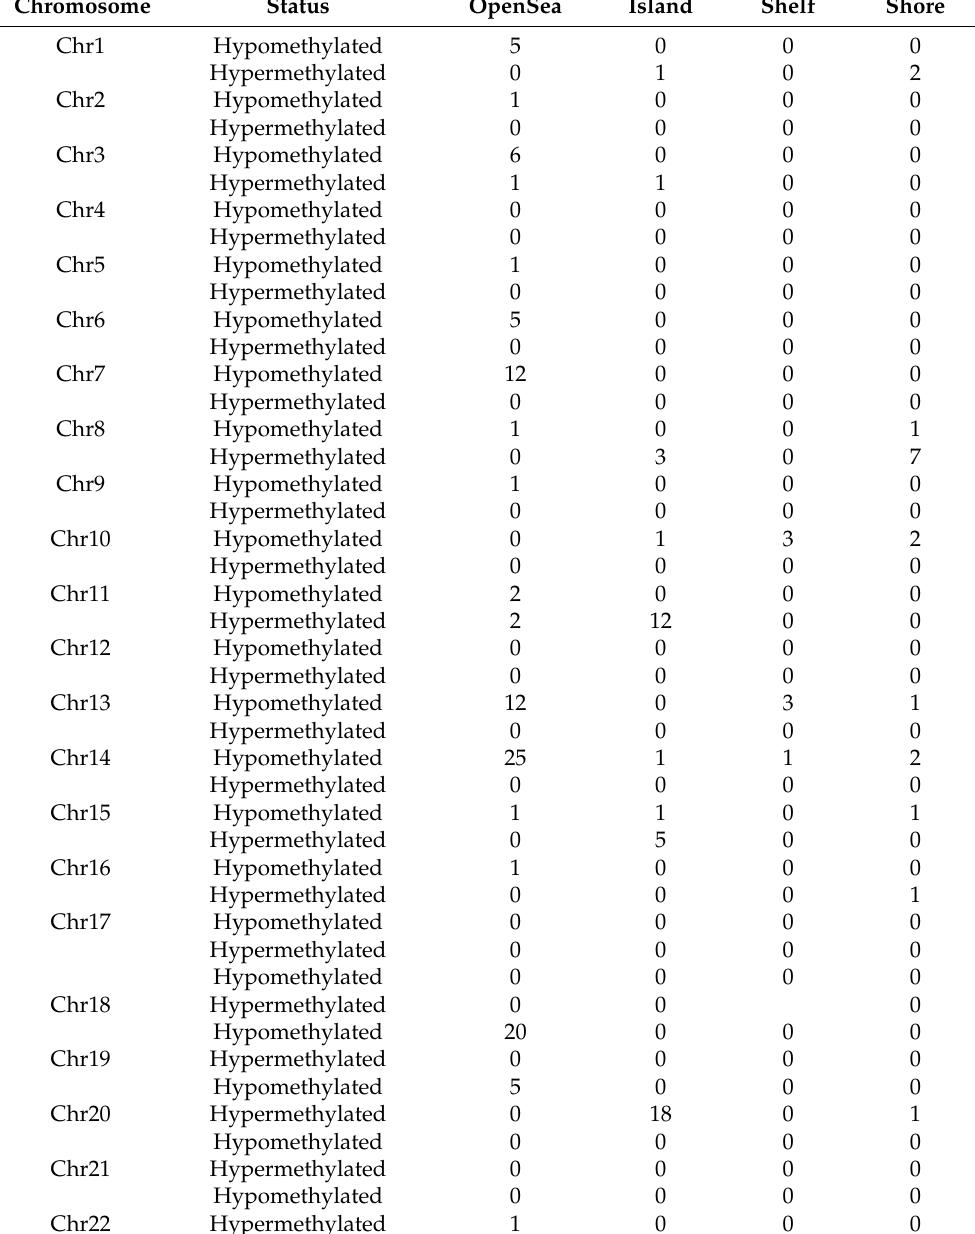
Table 2. Overview of miR-specific methylation changes across all chromosomes. The number of CpG hypermethylation and hypomethylation events in tumor as compared to normal tissue is shown, according to their neighborhood